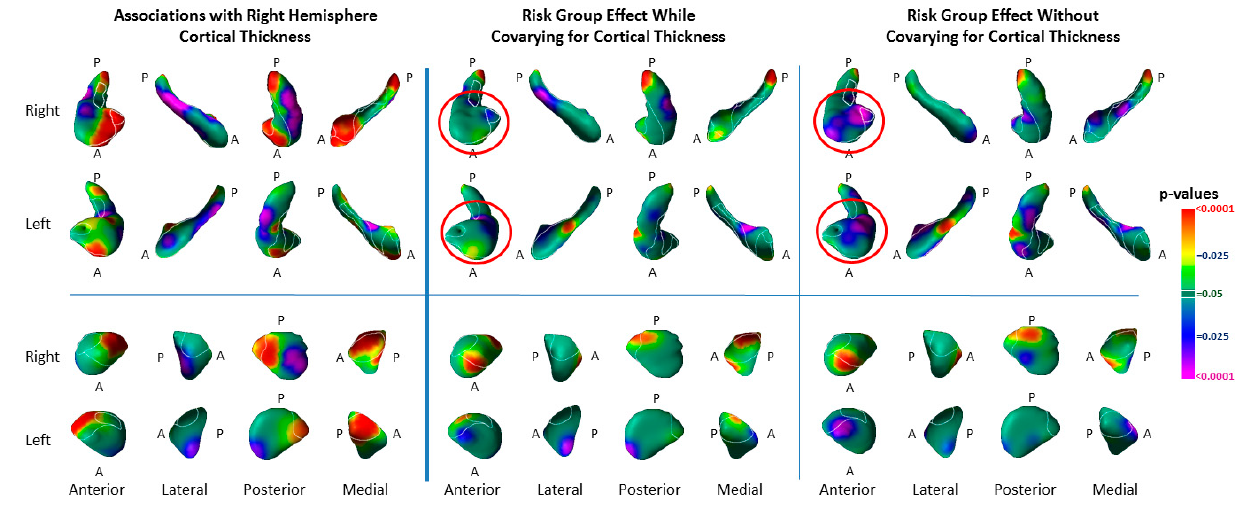
Figure 8. Associations of Right-Hemisphere Cortical Thickness with Surface Morphologic Features of the Hippocampus and Amygdala. Left Panel: The statistical significance ( p -values) for the associations of an index for right-hemisphere cortical thickness with surface measures on each structure are shown. Significant positive associations are in warm colors. Inverse associations are in cool colors. The index for right-hemisphere cortical thickness was calculated by averaging cortical thickness measures at each voxel within the voxels of the lateral surface of the right hemisphere, where thickness differed significantly between the high and low-risk groups. Statistical models included the independent variables cortical thickness, risk group, age, age 2 , and sex. Associations are shown for high- and low-risk groups combined (HR (64) and LR (65)). Middle Panel: This shows the effects of risk group while covarying for the average cortical thickness in voxels of the cortex where thickness differed significantly between risk groups, as well as covarying for age, age 2 , and sex. Right Panel: For ease of comparison with the middle panel, this shows the same effects without covarying for cortical thickness (also shown in Figure 1). The magnitude of cortical thinning accounted for most of the variance of the risk-group effect for indentations in the hippocampus (red circles), but not in the amygdala. Number of participants: covarying for cortical thickness—HR 63, LR 65; without covarying for cortical thickness—HR 81, LR 67.